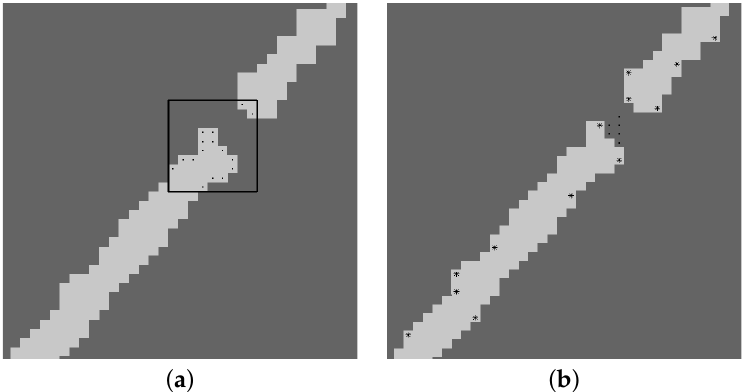
Figure 6. Interested branches pair of bridge extraction: ( a ) diagram of method based on contour distance; ( b ) diagram of method based on feature points